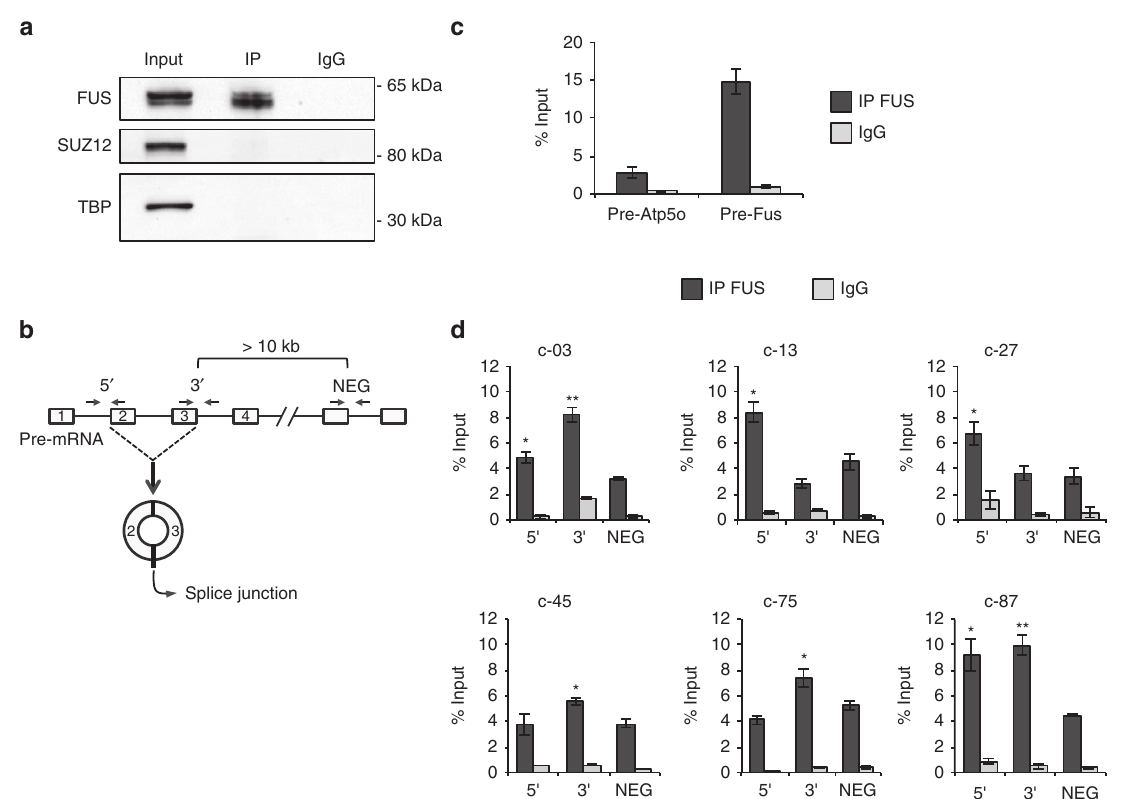
Figure 4 | FUS binds the introns flanking the circularized exons. ( a ) Protein extracts from FUS CLIP experiments, performed in differentiated N2a cells, were analysed by western blot with FUS antibodies and with SUZ12 and TBP antibodies as negative controls. Input samples account to 4% of the extract; IP and IgG represent 1/5 of the sample used for subsequent RNA analysis. ( b ) Schematic representation of the primers used for amplifying: the intron–exon junction upstream to the first exon included in the circRNA (5 0 ); the exon–intron junction downstream to the last exon included in the circRNA (3 0 ); the exon–intron junction at a distance of at least 10Kb away from circularizing exons (NEG). ( c ) Histogram show the levels of enrichment in IP FUS and IgG samples for the Atp5o pre-mRNA (negative control—pre-Atp5o) and for the region across exon 7 and intron 7 of the FUS pre-mRNA (positive control—pre-Fus). The values are measured as a percentage of the input. ( d ) Histograms show the levels of enrichment of 5 0 , 3 0 and NEG regions in IP FUS and IgG samples for six circRNA primary transcripts. The values are measured as a percentage of the input. For c , d , error bars represent s.e.m. of at least three independent experiments. * P o 0.05, ** P o 0.01 and *** P o 0.001 corresponds to two-tailed Student’s t